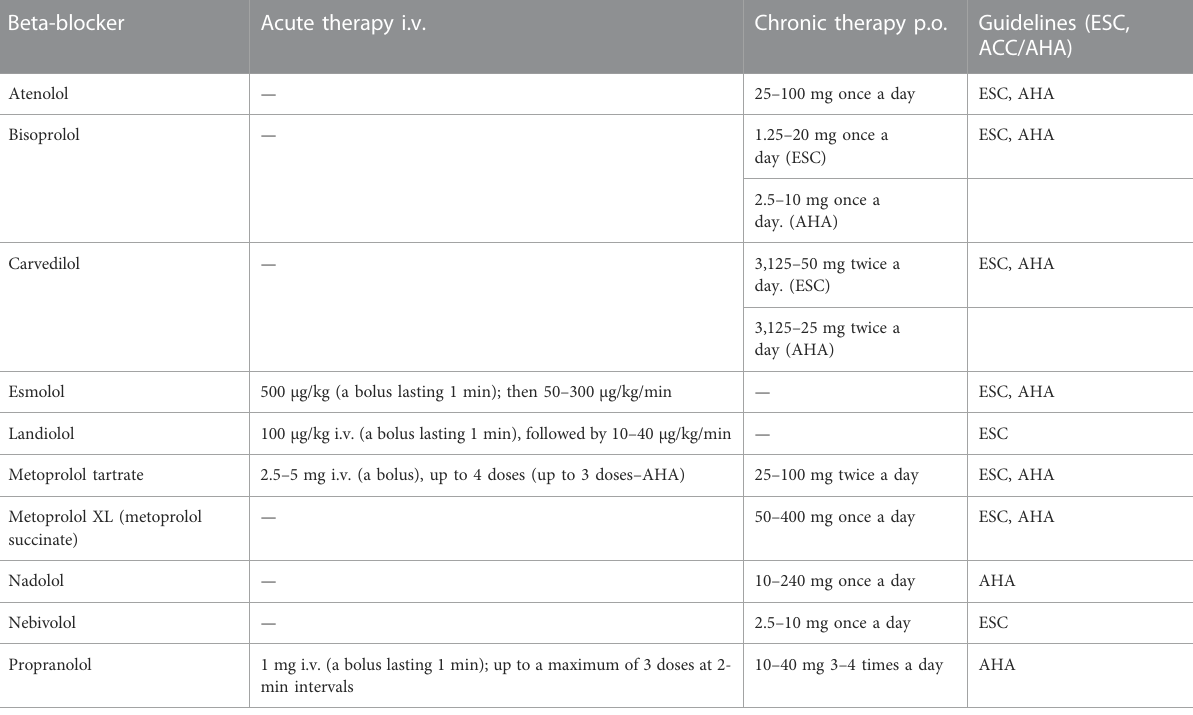
TABLE 6 Dosage of beta-blockers in the treatment of AF (January et al., 2014; Hindricks et al., 2021).